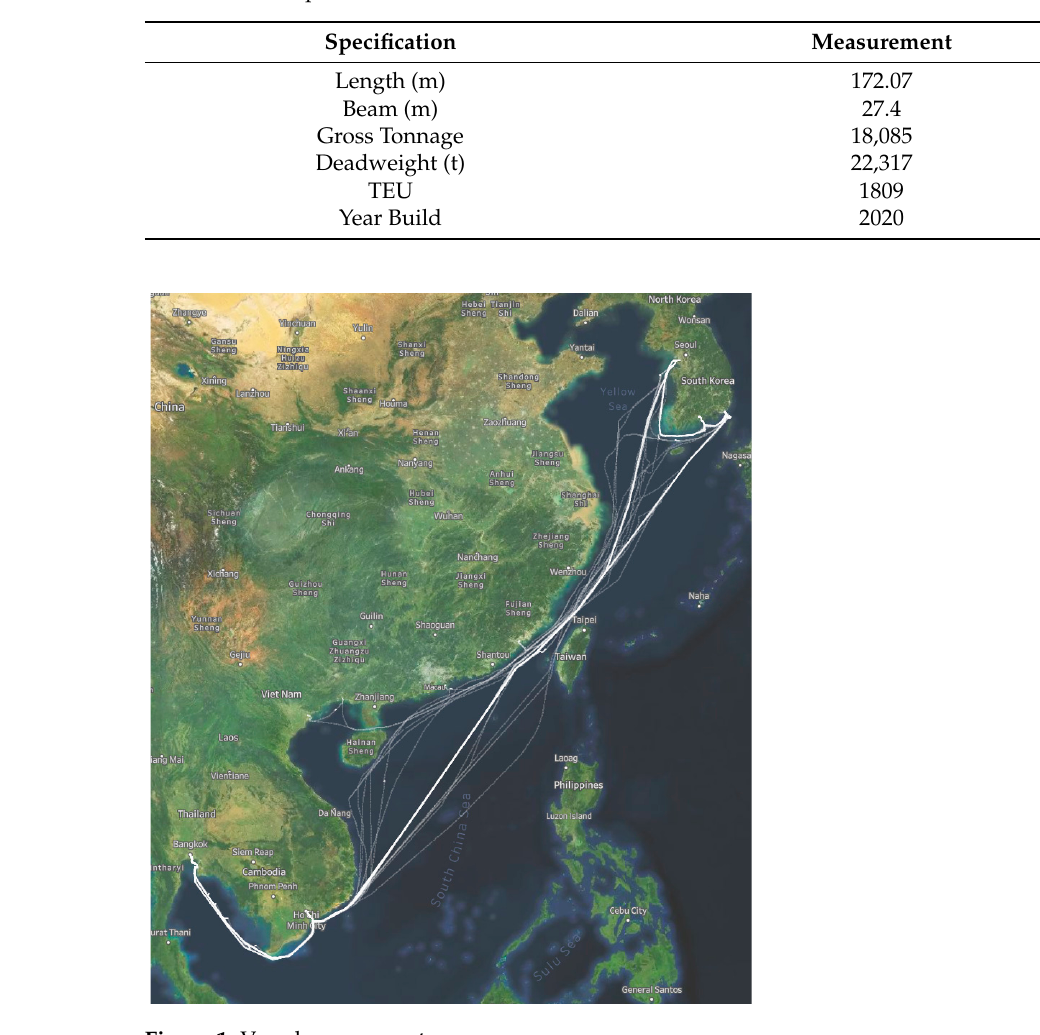
Figure 1. Vessel voyage routes.